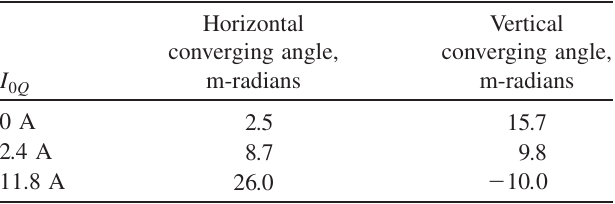
TABLE I. Optimization of quadrupole current.